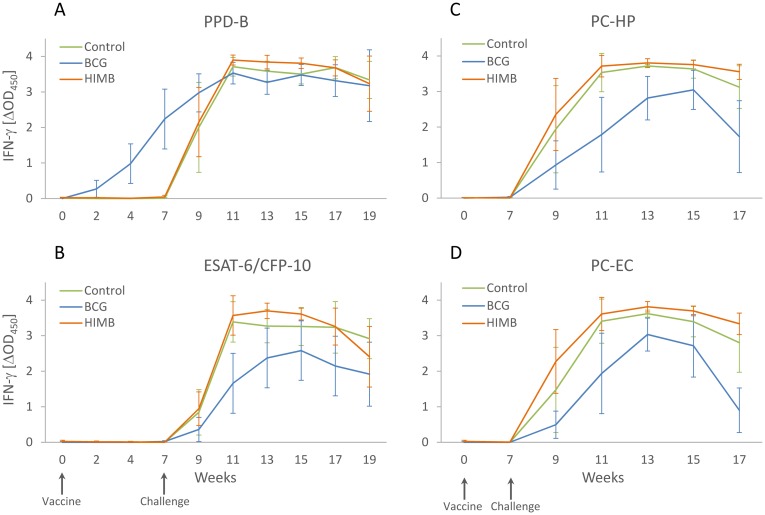
Whole blood antigen specific IFN-γ responses after vaccination and M. caprae challenge.The graphic shows the determination of the IFN-γ release by ELISA (expressed as ΔOD450 ± CI) in plasma supernatants after blood stimulation with (A) M. bovis PPD (PPD-B), (B) ESAT-6/CFP-10 recombinant antigens mixture, (C) PC-HP cocktail and (D) PC-EC cocktail in unvaccinated control (n = 6), BCG vaccinated (n = 6) and HIMB vaccinated (n = 6) lambs.